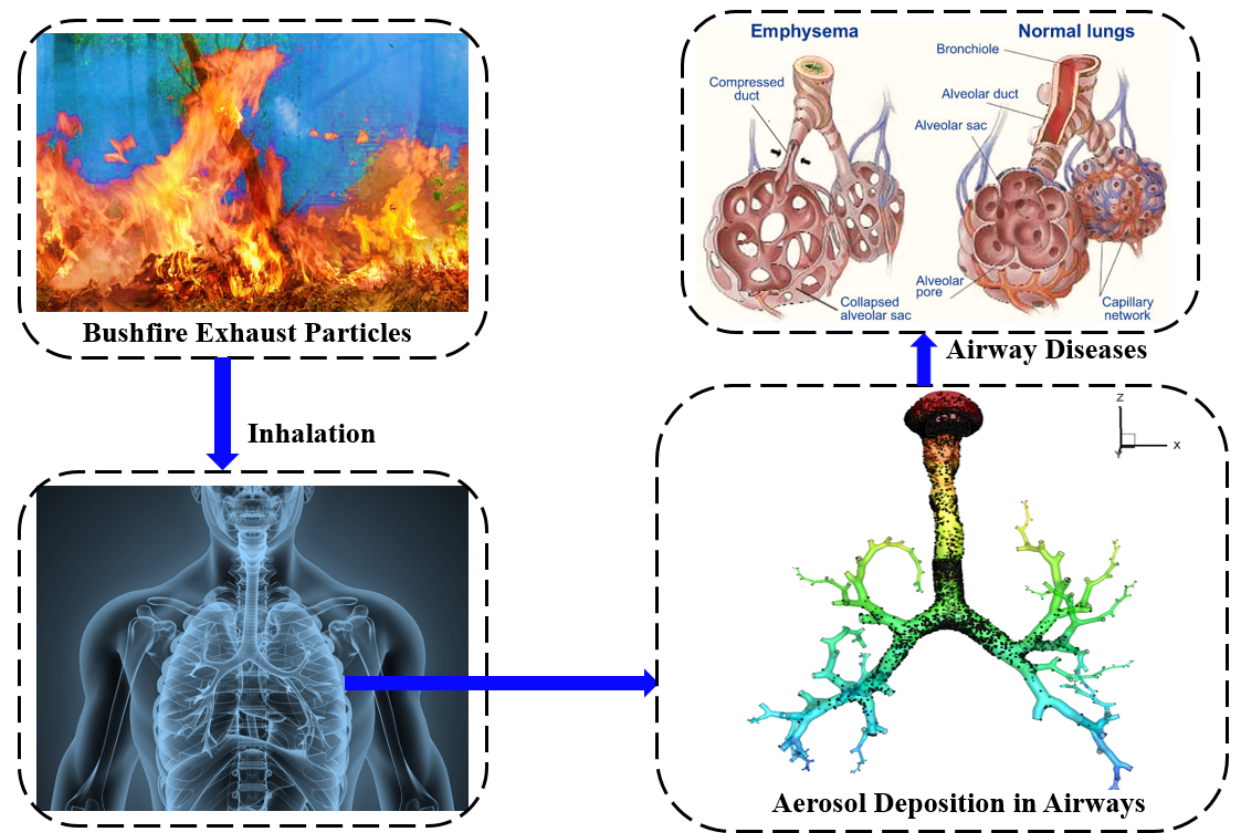
Figure 12. Respiratory health impacts of bushfire exhaust particles.